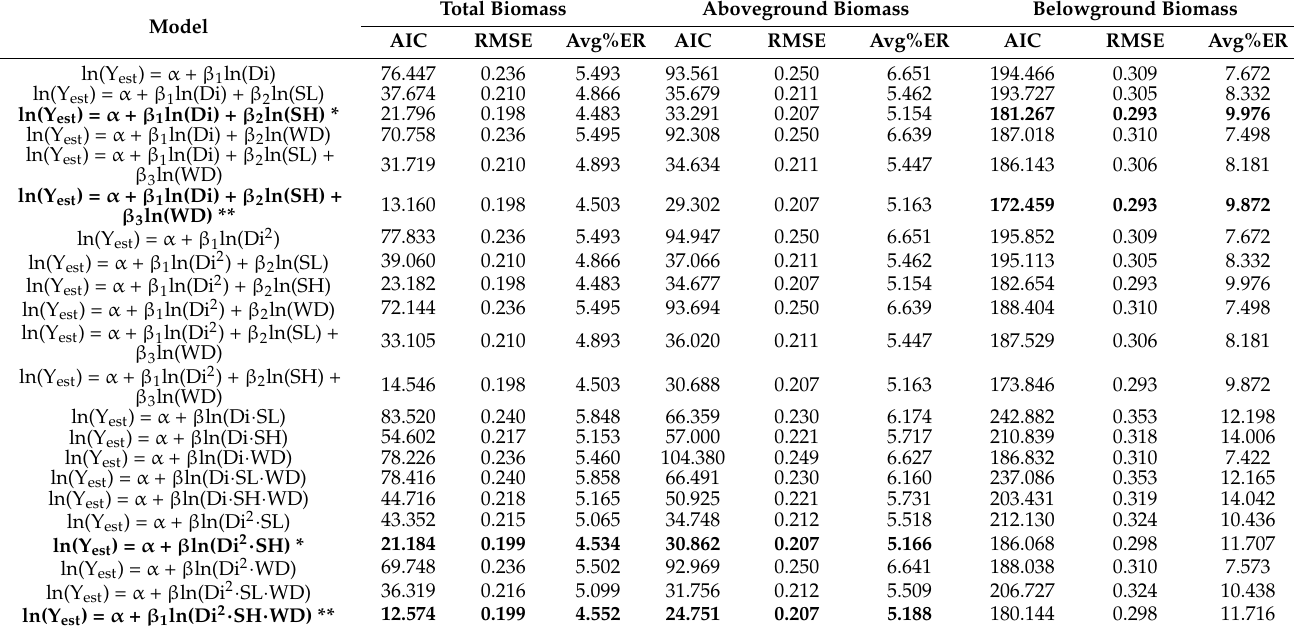
Table 2. Model effectiveness results reported in the value of AIC, RMSE (root mean square error), and Avg%ER (average percent error) of all candidate models. The performances of models are reported separately for total, aboveground, and belowground biomasses. The models in bold are the best performing model for each type of biomass. Di = root collar diameter, SH = shoot height, SL = shoot length, and WD = wood